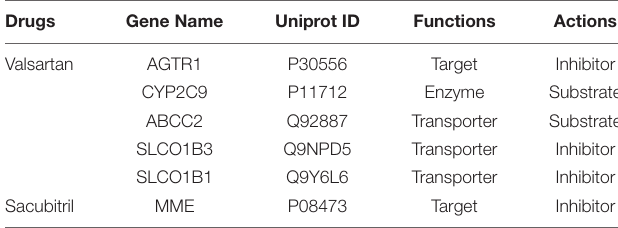
TABLE 1 | Direct protein targets of sacubitril/valsartan in DrugBank.